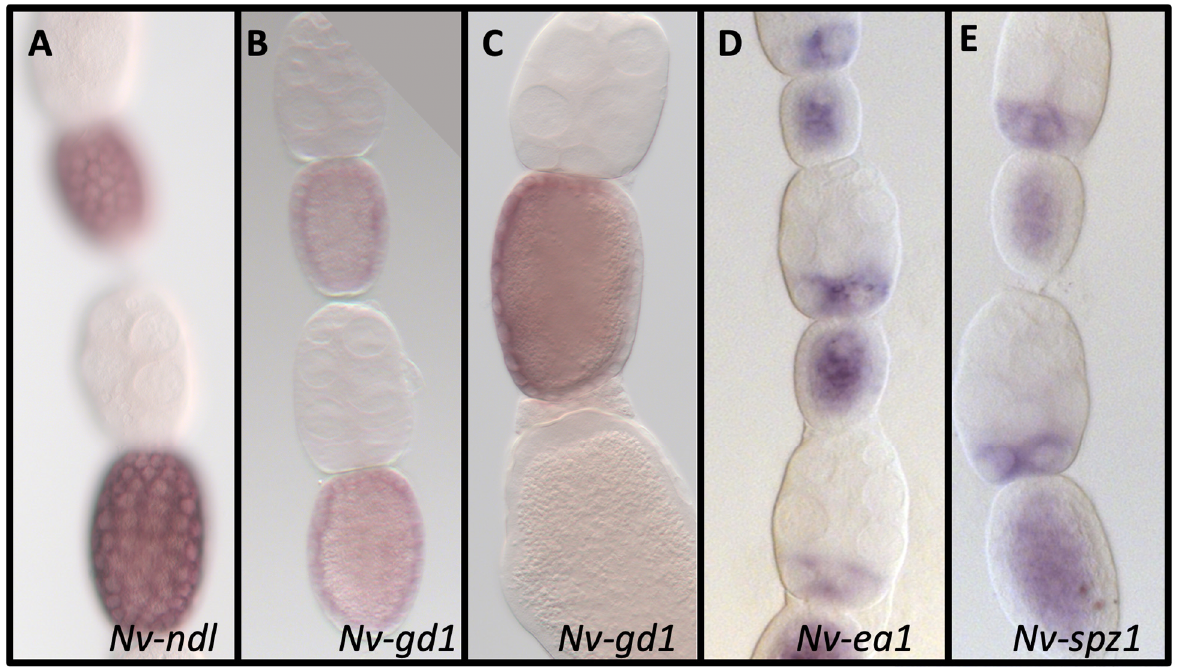
Figure 3. mRNA expression of proteolytic cascade components in the N. vitrpennis ovarioles. ( A ) Nv-ndl is ubiquitously expressed in follicle cells of mid- and late- (not shown) stage ovarioles, but not in germline cells. ( B ) In early- and mid-stage egg chambers, Nv-gd1 is expressed throughout the follicle cells. ( C ) Later, Nv-gd1 becomes restricted to only half of the follicle cells surrounding the late oocyte. ( D ) Nv-ea1 is expressed broadly in the oocyte from early stages (shown) on, but is restricted to only the posterior nurse cells. ( E ) Nv-spz1 is ubiquitously expressed in the oocyte and in the nurse cells. Anterior is at the top.